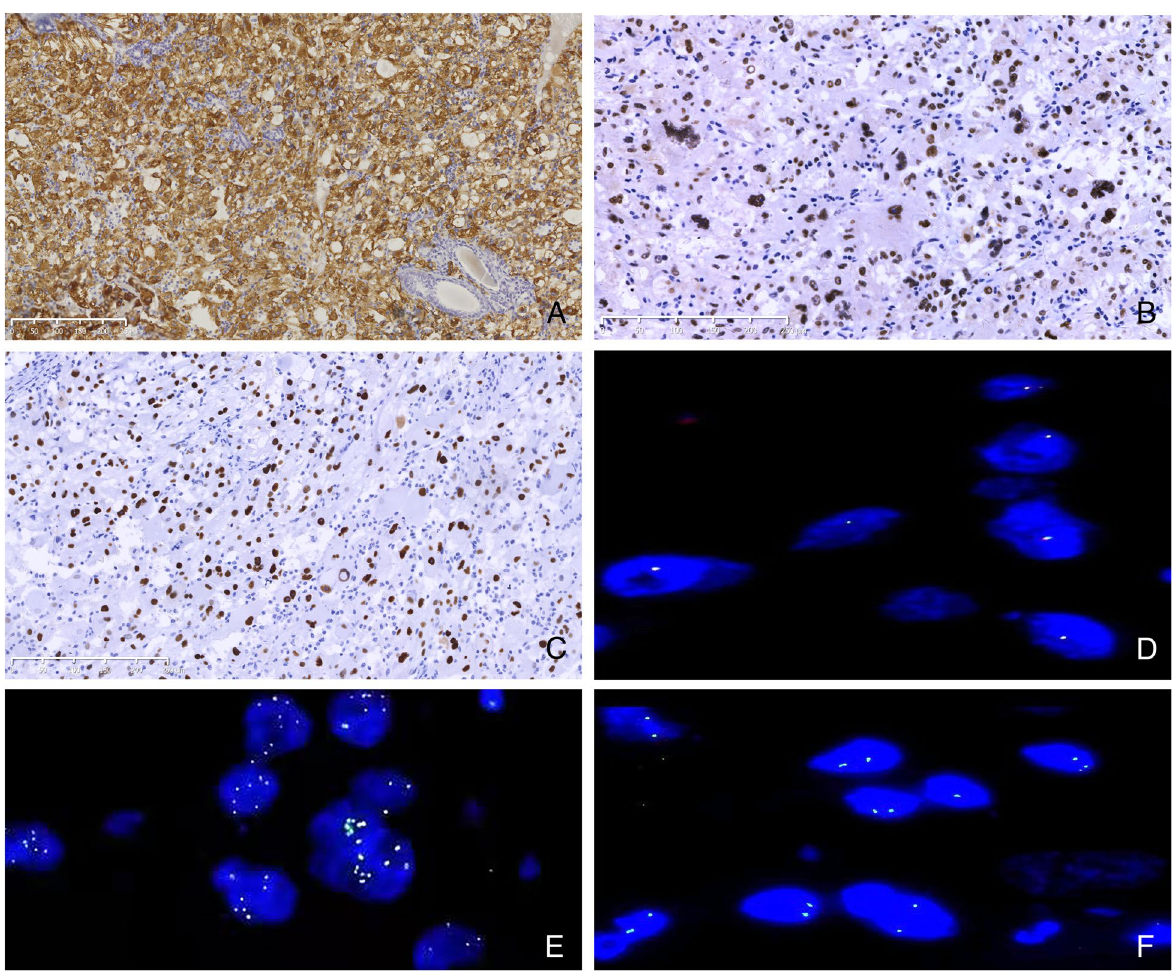
Fig. 1 The main abnormality of immunohistochemistry (IHC) staining and Fluorescence in situ hybridization (FISH) results. A All tumor cells were positive for HMB45 with IHC staining; B TFE3 was strongly positive in tumor nuclei with IHC staining; C p53 was strongly positive in all tumor cell nuclei with mutant expression pattern; D FISH analysis of TFE3 gene break, cases 5 (male) showed single yellow or red-green combined signal in neoplastic nuclei, indicating no evidence of TFE3 gene rearrangement; E TFE3 break-apart FISH image revealed that TFE3 amplification exists in cases 13 in which there are 3 to 8 copies of combination signals found in each neoplastic nucleus; F FISH with X centromere probe labeled 2 X chromosome centromeric signals in each neoplastic nucleus in cases 13 (female) which showed TFE3 gene